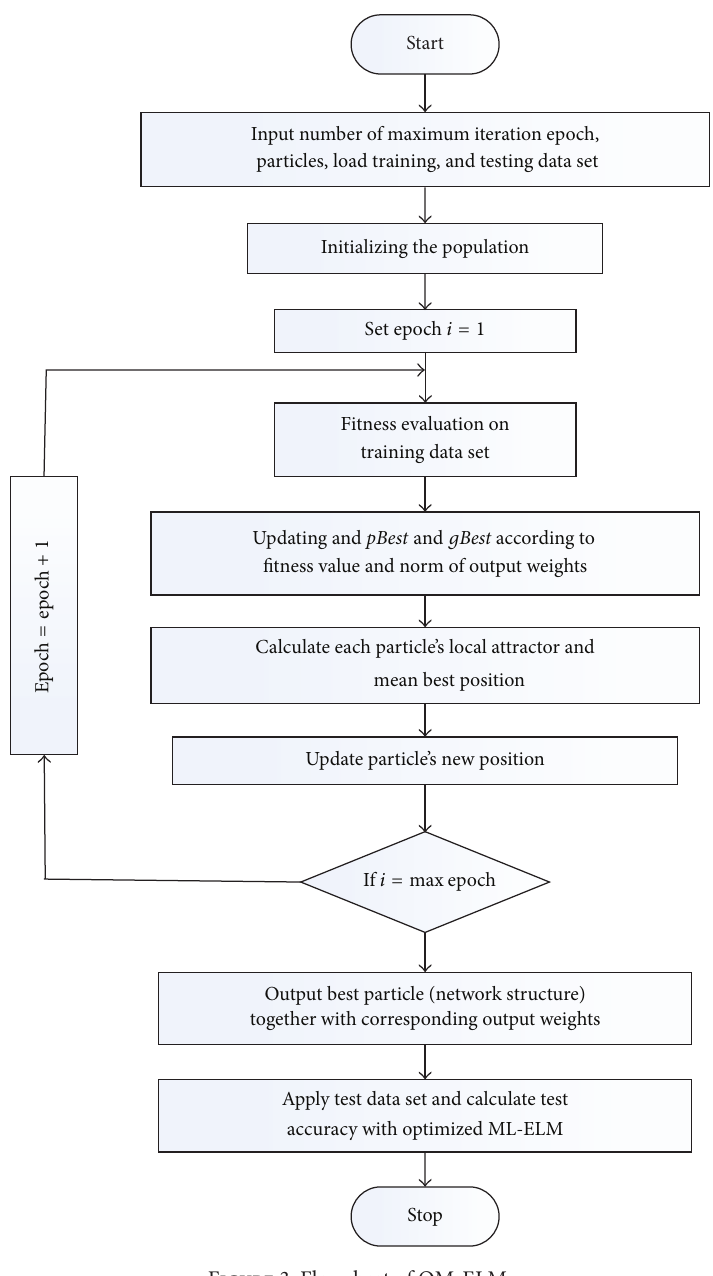
Figure 3: Flowchart of